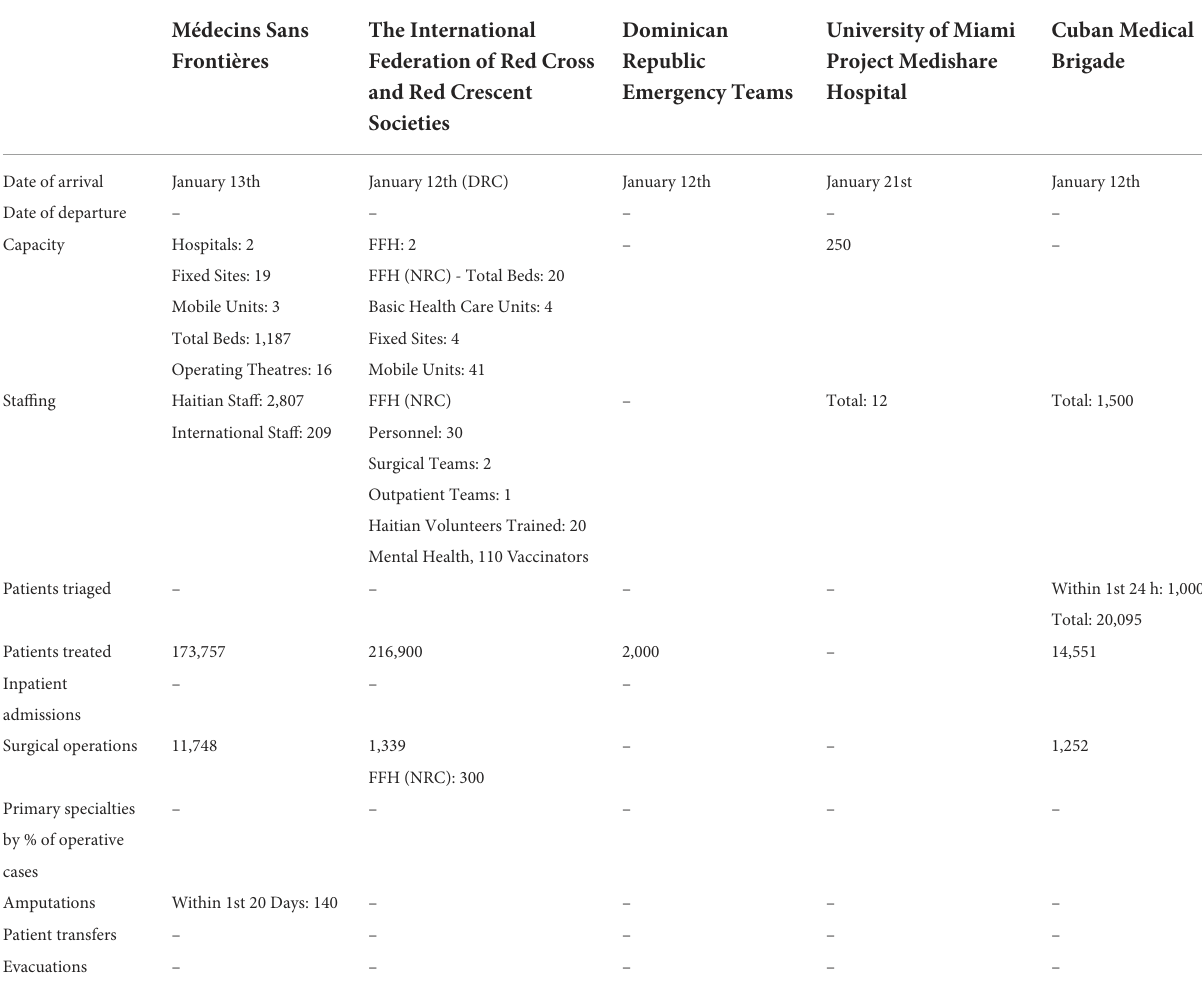
TABLE 8 Summary of healthcare operations: international